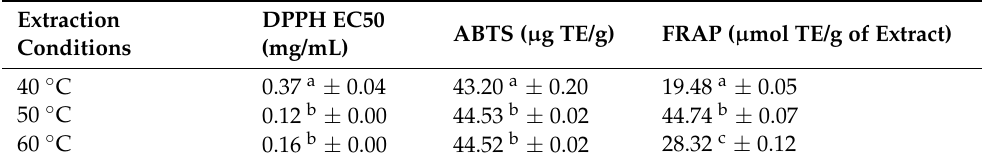
Values are mean ± s.d., n = 3, values with the same lowercase letters in the same column indicate no significant difference at level of 5% ( p <